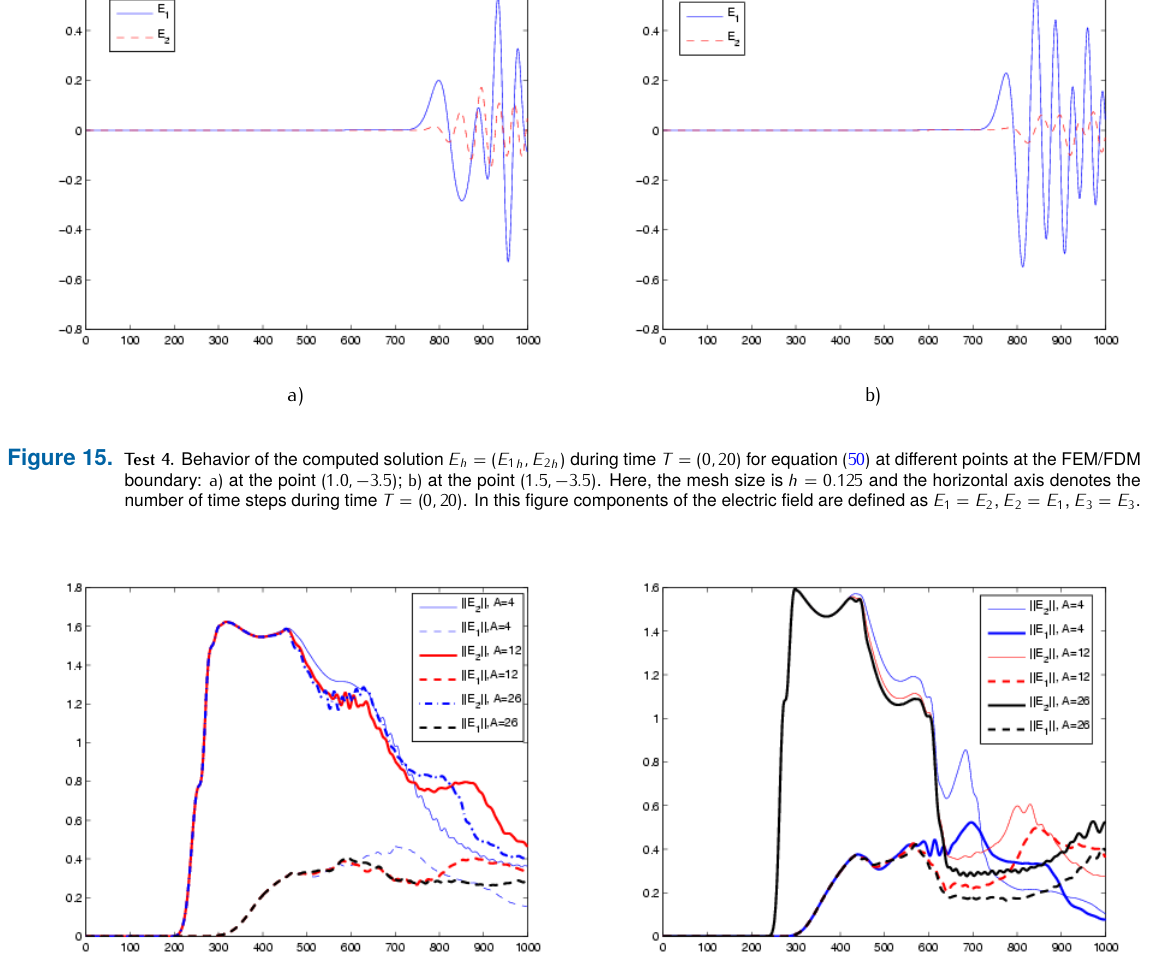
Figure 16. Test 4. Comparison of the computed L -norms for kE k and for kE k on different meshes with mesh sizes h = 0 . 05 and h = 0 . 125 , 2 1 h 2 h respectively. L -norms are shown during time T = (0 , 20) in Ω . Computations are performed with different amplitudes A in the 2 FEM definition (53) of the coefficient ε ( x ) inside Ω . Here, the horizontal axis denotes the number of time steps during time T = (0 , 20) . FEM